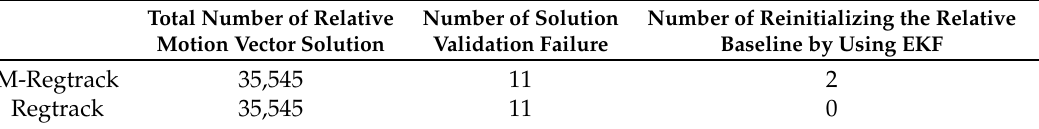
(cid:113) + err 2 err 2 N E